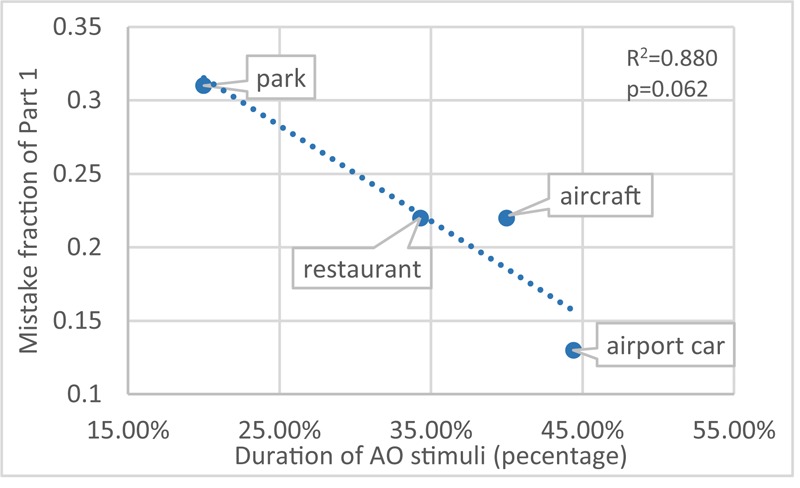
Correlation between duration (%) of AO stimuli and M1.